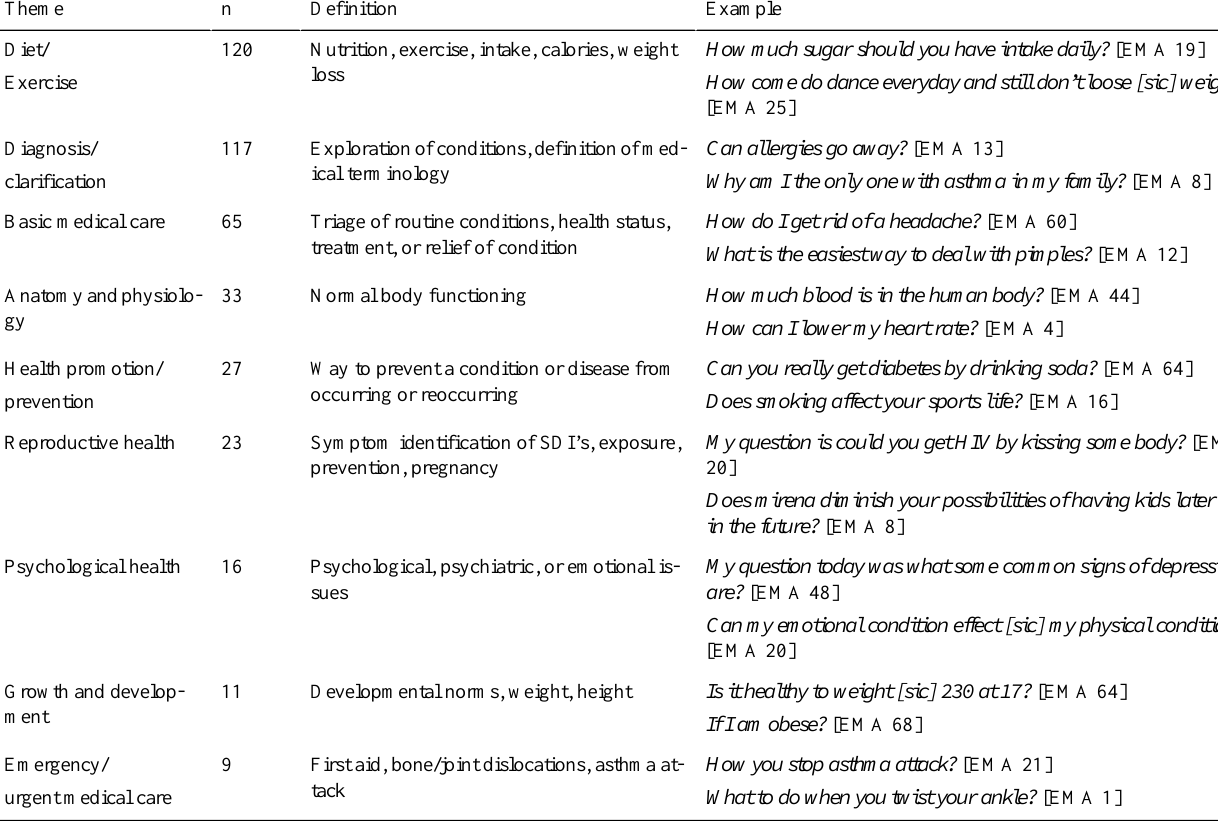
Table 2. Themes of health information needs and sample quotes.